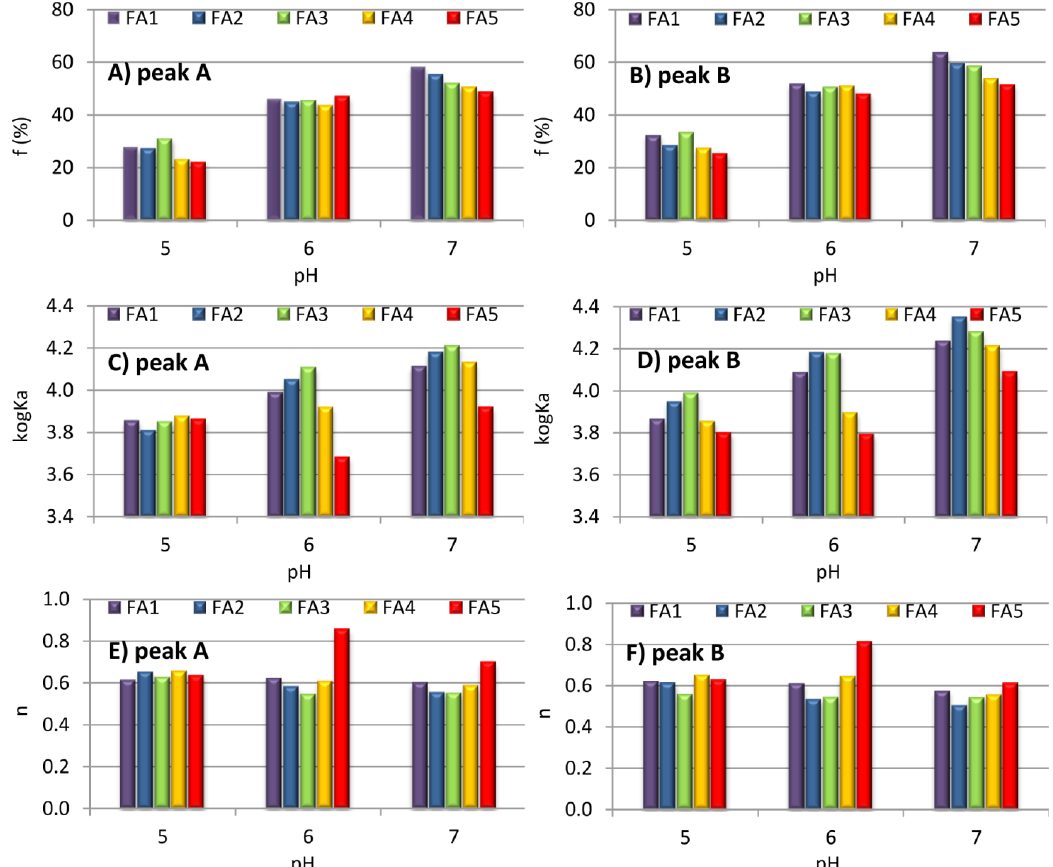
Figure 4. Changes of the binding parameters of FA-Zn(II) complexes as a function of the pH for A and B peaks: ( A , B ) fraction of the accessible fluorophores; ( C , D ) conditional stability constant; ( E , F ) number of binding sites.